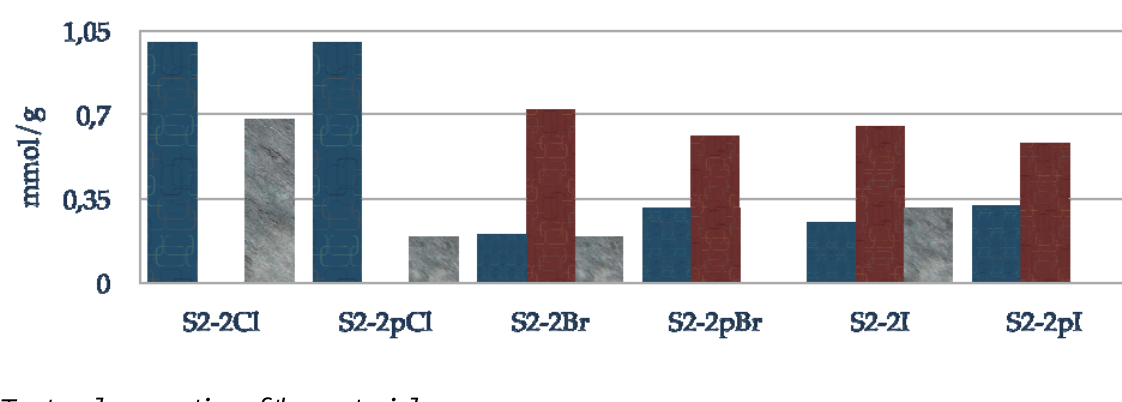
Figure 7. Composition of supported oxazaborolidine through nitrogen substituent; blue: halogeno species, red: chemisorbed amino alcohol, grey: physisorbed amino